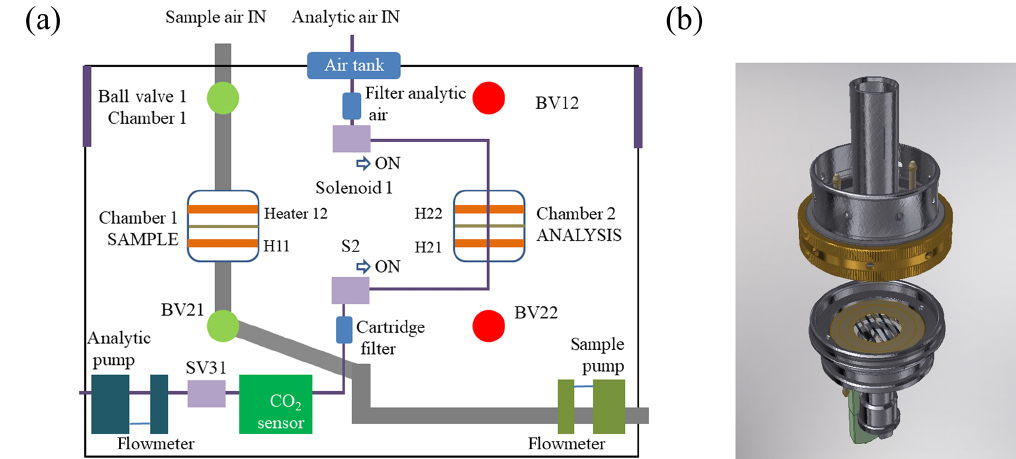
Figure 1. (a) The TCA08 flow diagram. While chamber 1 collects a new atmospheric sample on the quartz-fiber filter, chamber 2 performs a thermal analysis of the previously collected sample. The system of ball valves (BV11, BV21, BV12, BV22) and solenoids (S1 and S2) change the airflows after the sample time base. (b) The analytical chamber of the TCA08 Total Carbon Analyzer is made of stainless steel. It supports the quartz-fiber aerosol collection filter between two closely spaced heating elements, one above and one below.